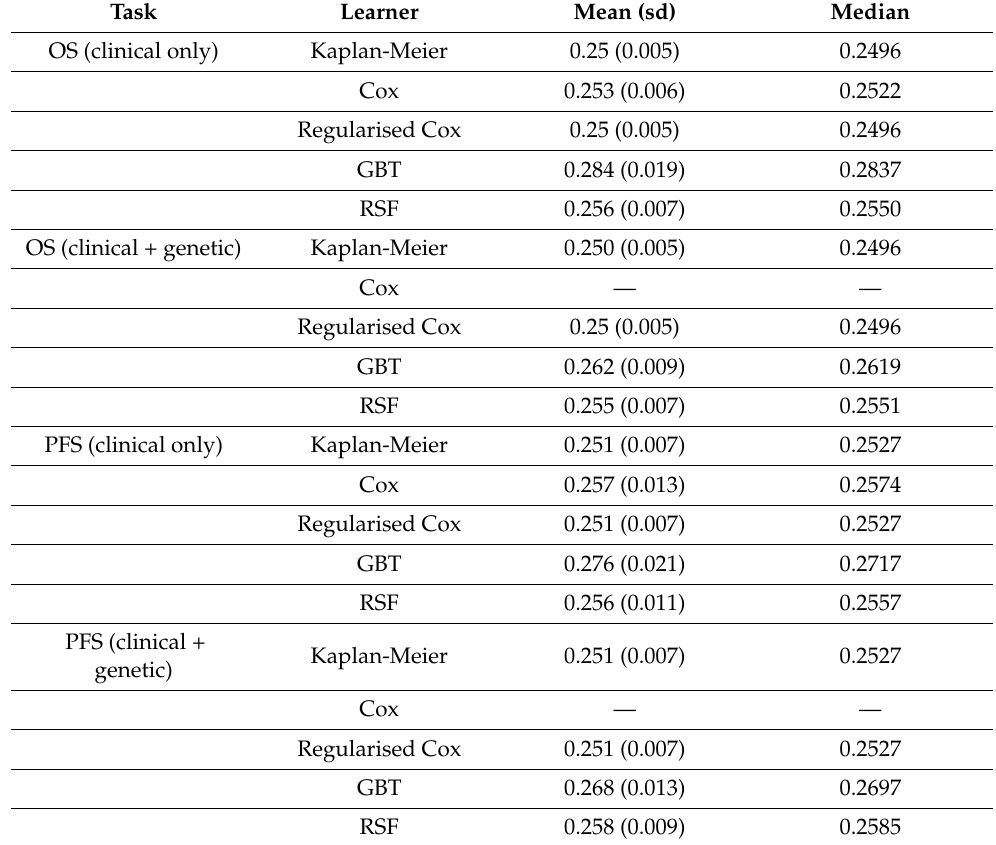
Table 2. Benchmark experiments with respect to overall survival and progression-free survival. Aggregated predictive performance of five learners based on 25 values of the IBS. Lower values indicate better performance. Performance of the unregularised Cox model is omitted for the high- dimensional setting (data with genes). Performance of KM is identical between the different settings (clinical only vs. clinical + genetic). Task Learner Mean (sd) Median OS (clinical only) Kaplan-Meier 0.25